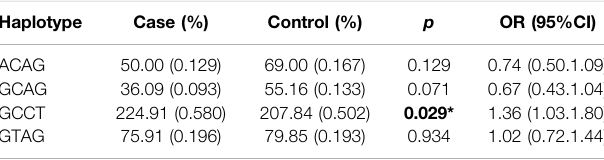
TABLE 10 | Haplotype frequencies of ADD1 polymorphisms and EH risk in Han population.